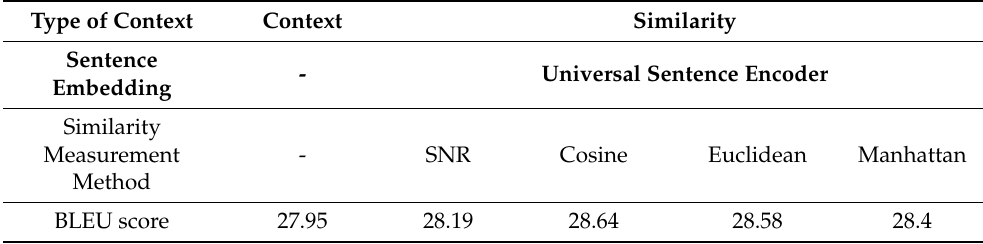
Table 3. BLEU scores of IWSLT’14 English to German model by type of context.